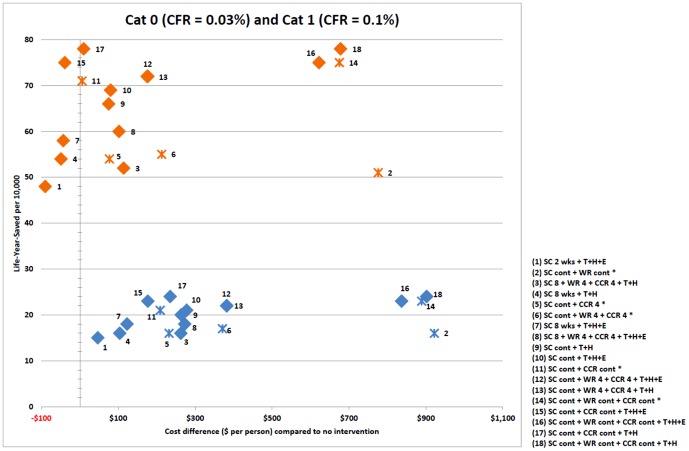
Intervention strategy cost effectiveness plane for severity category 0 and category 1 with death related productivity losses.Cost effectiveness for each intervention strategy is plotted as a point in a two-dimensional plane for severity category 0 (case fatality ratio 0.03%) (blue points) and category 1 (case fatality ratio 0.1%) (orange points). Horizontal axis represents the cost of the intervention strategy as a difference in total cost between two scenarios; an outbreak with the intervention in place and an outbreak with no interventions, expressed as dollars per member of the population. Vertical axis represents the number of life years saved by each strategy: the difference in life years lost for an outbreak with and without the strategy in place, expressed as life years saved per 10,000 population members. Both costs (death related productivity losses) and LYS are discounted. Strategies involving antiviral drugs are marked as diamonds; purely social distancing strategies are indicated with a cross. Each strategy is numbered, with the intervention components and durations making up the strategy given in the legend within the figure. Interventions are abbreviated as follows: SC – school closure; CCR – 50% community contact reduction; WR – 50% workforce reduction; 4, 8 – intervention duration in weeks; cont – continuous duration; T – antiviral treatment of diagnosed symptomatic cases; H – antiviral prophylaxis of household members of diagnosed symptomatic cases, E – antiviral prophylaxis of school class or workplace contacts of diagnosed symptomatic cases.